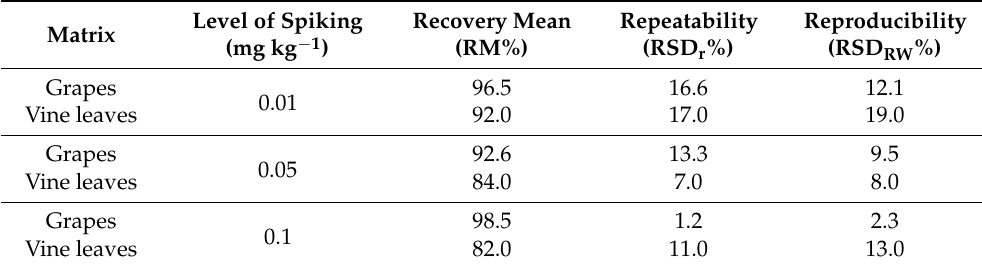
Table 5. Method validation results showing the average of recovery data (RM%), repeatability (RSD r %) and reproducibility (RSD Rw %) for imidacloprid at the three fortification levels, 0.01, 0.05 and 0.1 mg kg − 1 ( n = 5 at each level) in grapes and vine leaves